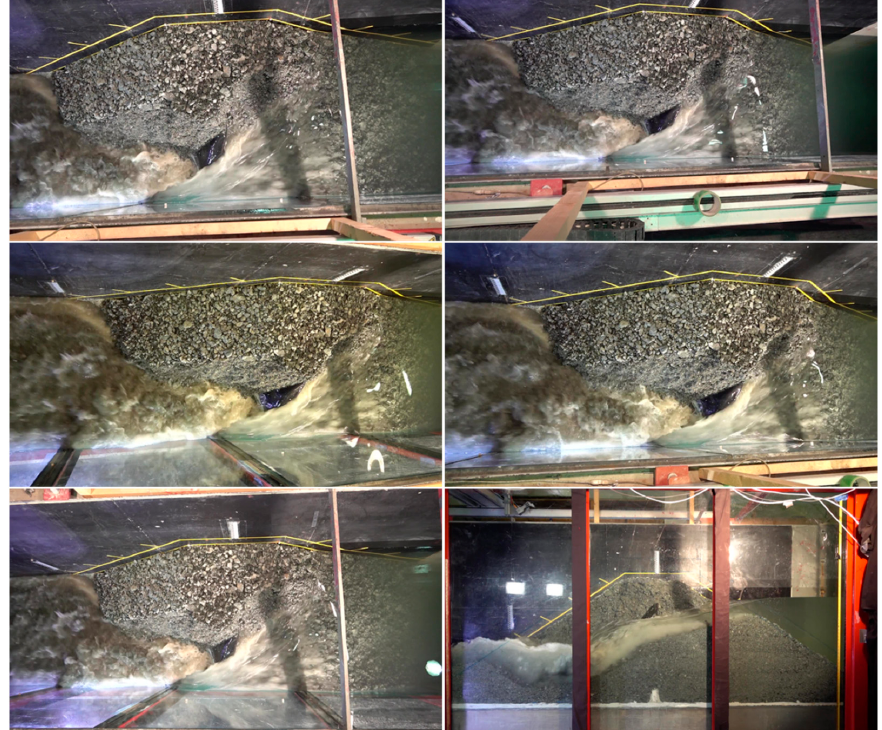
Figure 6. Example set of synchronised images from test U4—3170 s from start of test.